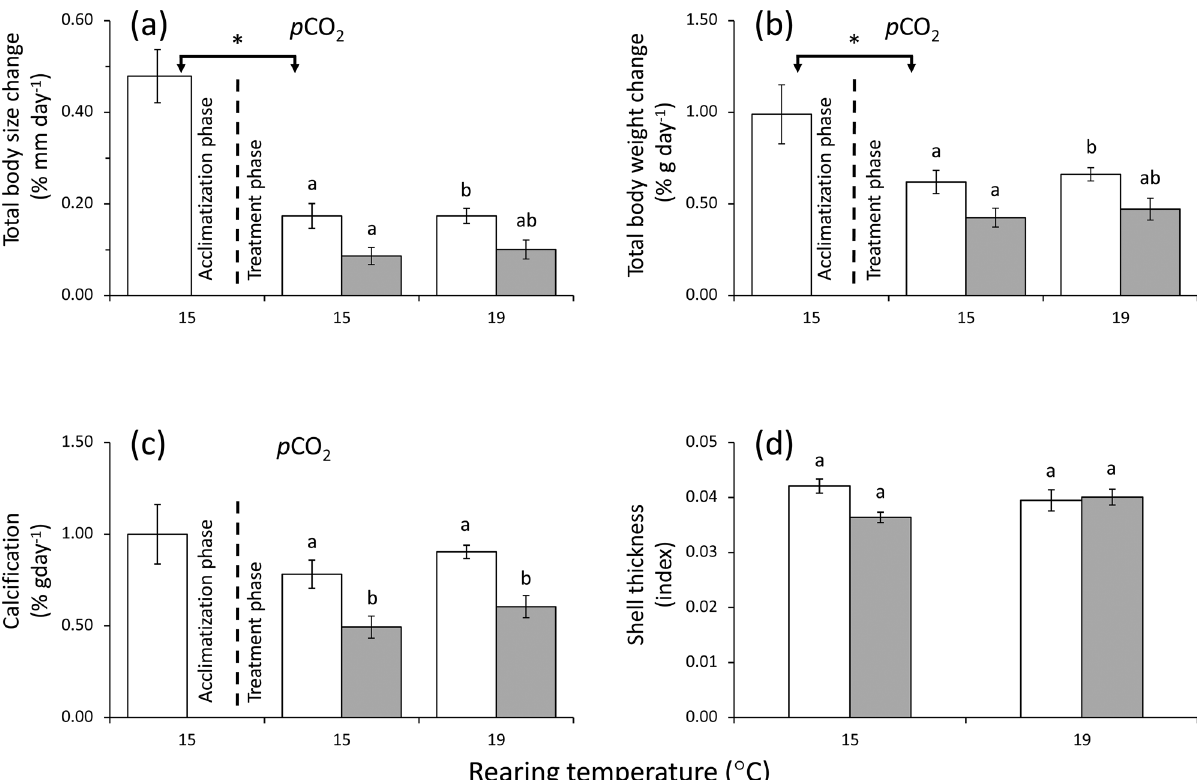
Fig 2. Concholepas concholepas. Effect of two different levels of p CO 2 and temperature on the (mean ± SE) (a) percentage of total body size increase; (b) percentage of total body wet weight increase; (c) net calcification rate and (d) shell thickness index of small juvenile individuals reared for 5.8 months in the experimental conditions. For each panel, the designations ‘ p CO 2 ’ indicate significant p CO 2 (two-way ANOVA). Open and filled bars represent measurements at current-day and high p CO 2 levels respectively. Different letters above the bars indicate significant differences (p < 0.05) in Tukey's HSD post hoc test on the 2-way ANOVA analysis. The * above the open bars represent significant differences (p < 0.05) on the 1-way ANOVA analysis comparing the acclimatisation and the treatment phase at 15°C.